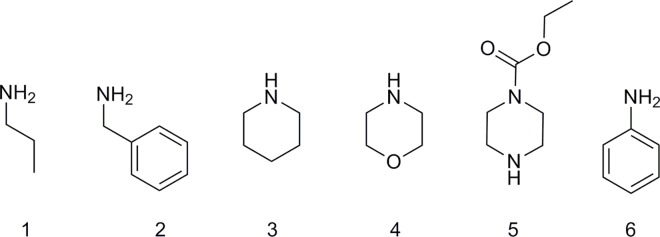
Amines used for synthesis of carboxamides 9(R1,X, R2).